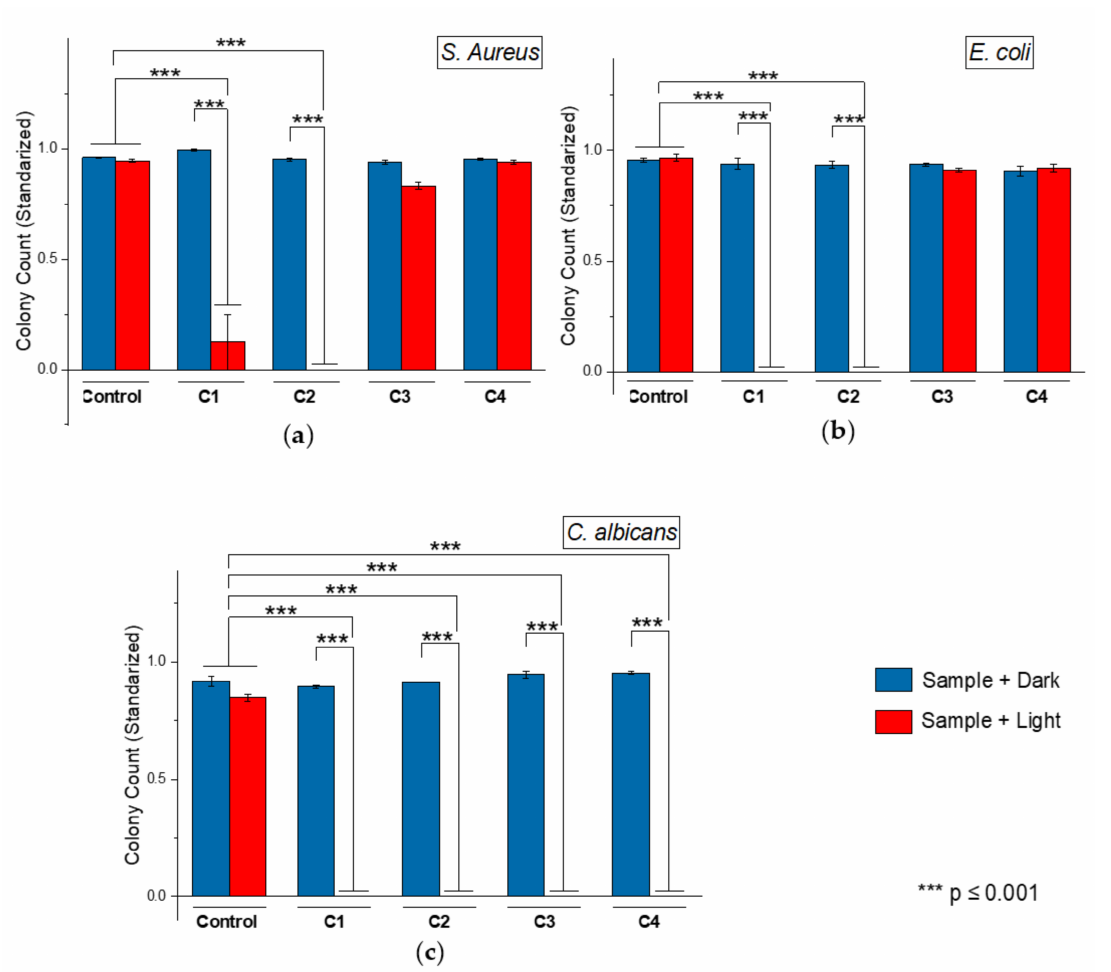
Figure 10. PDT/PTT antimicrobial effect. Standardized result of LOG(UFC/mL) by ( a ) S. aureus; ( b ) E. coli and ( c ) C. albicans based in C1, C2, C3 and C4 nanocomposites. The concentration of